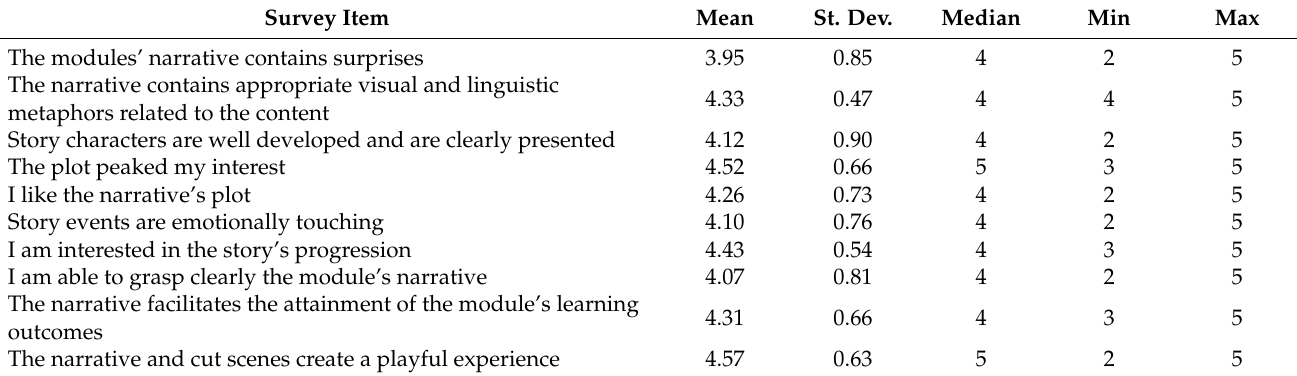
Table 4. Descriptive statistics on the evaluation of instructional and affective elements of playful